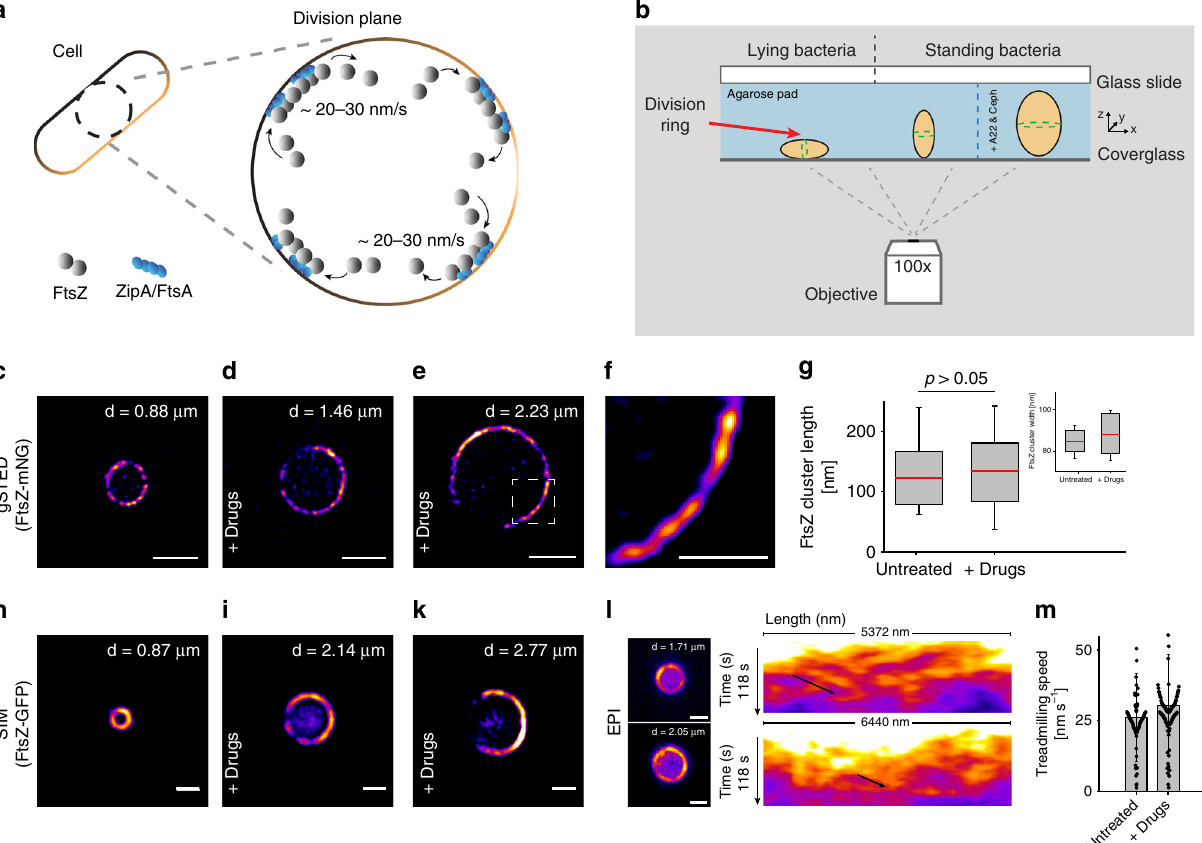
Fig. 1 Midcell FtsZ-ring assembly is unaffected by increased cell diameter. a Simpli fi ed cartoon showing FtsZ treadmilling at the division plane of an E. coli cell. For clarity, only FtsZ (gray dots), it ’ s membrane tethers, FtsA and ZipA (blue dots), and the membrane (brown) are shown. b Schematic representation of cell placement for imaging. Green dotted ring in the cells represents the FtsZ-ring (red arrow). Standing cells were trapped in a vertical position in micron-sized holes in agarose pads created using micron-sized pillars. Conditions for proper division ring placement are met when width < length. The left and middle cells represent untreated cells. The cell on the right has increased dimensions due to drug exposure (A22 and cephalexin). c Time-gated STED (gSTED) image of a typical FtsZ-ring (FtsZ-mNeonGreen) in an untreated standing cell. Scale bar = 1 μ m. d , e gSTED images of FtsZ- mNeonGreen rings in E. coli cells treated with drugs, showing increased ring diameter. Scale bar = 1 μ m. Drugs refer to A22 and cephalexin. f Close-up of representative FtsZ clusters shown in e , from a cell with increased diameter. Scale bar = 0.5 μ m. g Quanti fi cation of FtsZ cluster lengths in untreated and drug-treated cells. Mean± S.D. was 122.8 ± 43.9 nm ( n = 77) and 132.4 ± 48.7 nm ( n = 172) for untreated and drug-treated cells, respectively. No statistically signi fi cant difference was measured, p > 0.05. Inset shows cluster widths in untreated (mean ± S.D. = 86.1 ± 6.3 nm ( n = 77)) and drug-treated cells (mean ± S.D. = 88.4 ± 9.8 nm ( n = 172)). Boxes represent S.D., with red lines indicating mean. Whiskers on the box plots encompass 95.5% of the distribution. h – k Structured illumination microscopy (SIM) images of FtsZ-GFP in E. coli cells ( h ) untreated or ( i – k ) treated with drugs. Scale bars = 1 μ m. l Snapshots of epi fl uorescence (EPI) images from time-lapse series of FtsZ-GFP dynamics in drug-treated cells. Scale bars = 1 μ m. Corresponding kymographs are shown adjacent to each image. Black arrows point to examples of FtsZ trajectories. m Average treadmilling speed of FtsZ-GFP in untreated (mean ± S.D. = 26 ± 15 nm s − 1 , n = 102) and drug-treated cells (mean ± S.D. = 30 ± 18 nm s − 1 , n = 102). Black dots represent individual data points, bars represent mean with error bars representing S.D. “ d ” in c – e , and h – l indicates cell